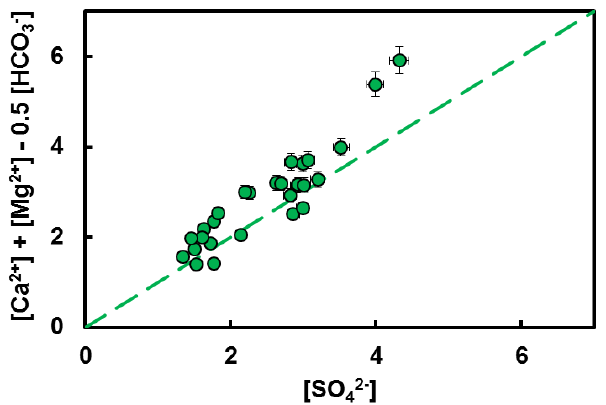
Figure 2. Ca 2 + concentration reduced by the proportion gained from CaCO 3 dissolution by considering dolostone dissolution ([Ca 2 + ] + [Mg 2 + ] – 0.5 [HCO − ], mM) vs. the concentration of 3 dissolved SO 2 − , [SO 2 − ] (mM). The linear relationship with a slope 4 4 of 1 fits the composition of the Hasouna groundwaters quite well and reflects the dissolution of CaSO 4 minerals like